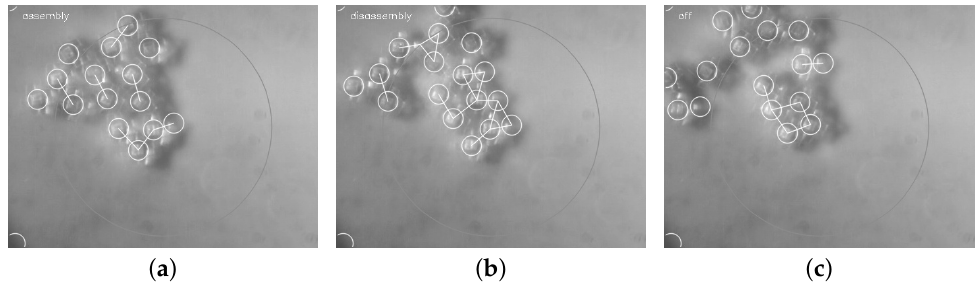
Figure 10. Self-assembly sequence for a large microparticle set. Dimensions of the target cluster: five [10]. ( a ) 7.04 s, assembly mode; ( b ) 7.24 s, disassembly mode; ( c ) 7.68 s, target structure achieved.